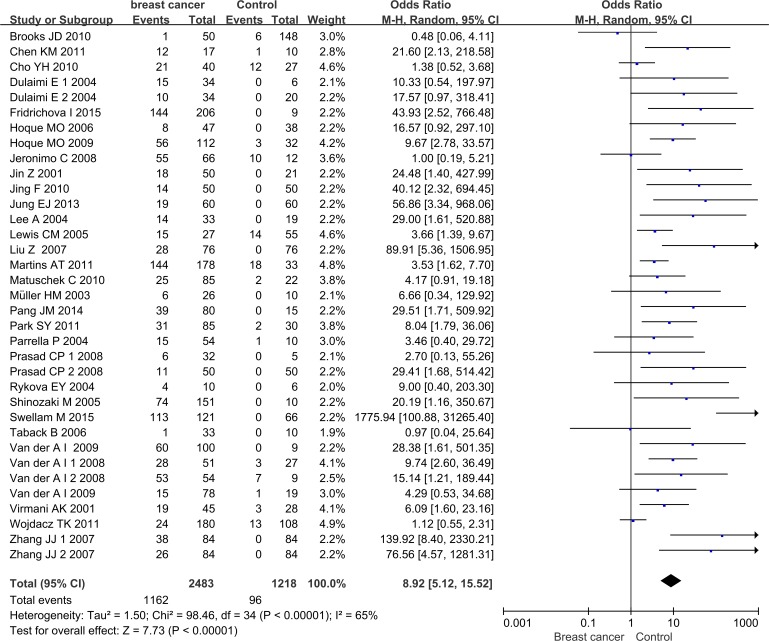
Forest plot of APC promoter methylation and breast cancer risk based on the random effects model.The small squares and horizontal lines represent the OR and 95% CI of individual studies. If the 95% CI included 1, the difference in APC methylation between patients with breast cancer and controls was not significant. The centre of the diamond represents the combined treatment effect (calculated as a weighted average of individual ORs) and the horizontal tips represent the 95% CI. OR represents the odds ratio. 95% CI represents the 95% confidence interval.